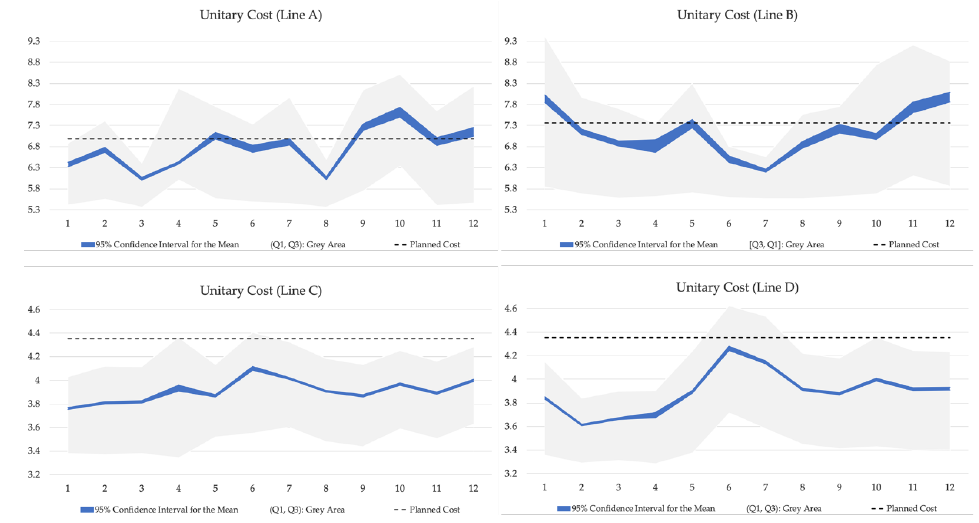
Figure 6. Stochastic cost analysis, per line. Values in euros for each of the 12 weeks. Starting with lines A and B, we see that costs vary over time, above or below what was planned. Lines C and D tend to present their mean costs lower than planned. The upper limits (i.e., the 3rd quartile values) for the small lines are almost twice as high as for the big lines. In the big lines, values vary between EUR 3.3 and 4.7, while in the small lines, they can reach maximum values of around EUR